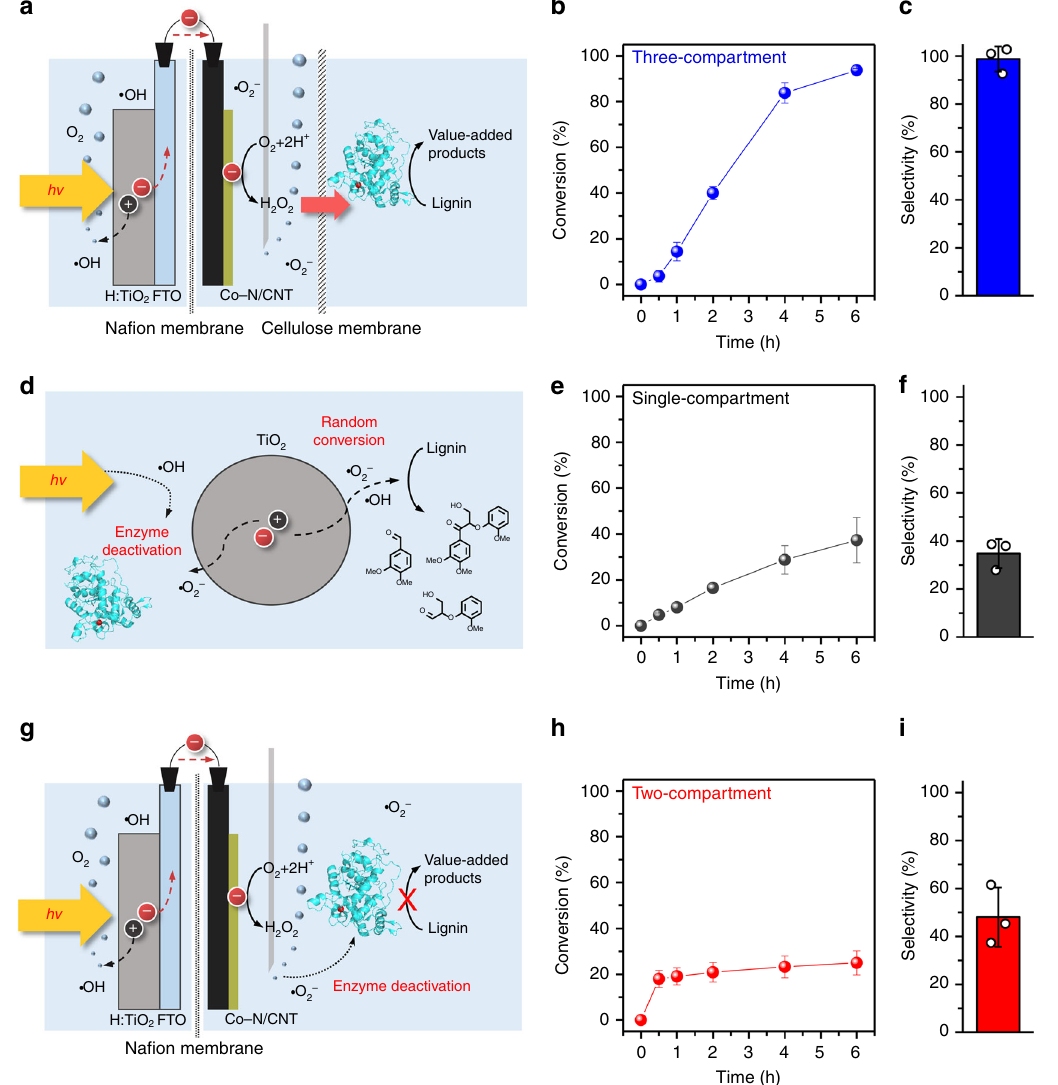
Fig. 3 Reactor con fi gurations and photo-electro-biochemical lignin dimer conversion. a , d , g Schematic representations of the three-compartment photo- electro-biochemical system ( a ), single-compartment powder-based photo-biochemical system ( d ), and two-compartment photo-electrochemical system ( g ) used for lignin dimer conversion. b , e , h Conversion and c , f , i selectivity of the three-compartment photo-electro-biochemical system ( b , c ), single- compartment powder-based photo-biochemical system ( e , f ), and two-compartment photo-electrochemical system ( h , i ). Error bars indicate the